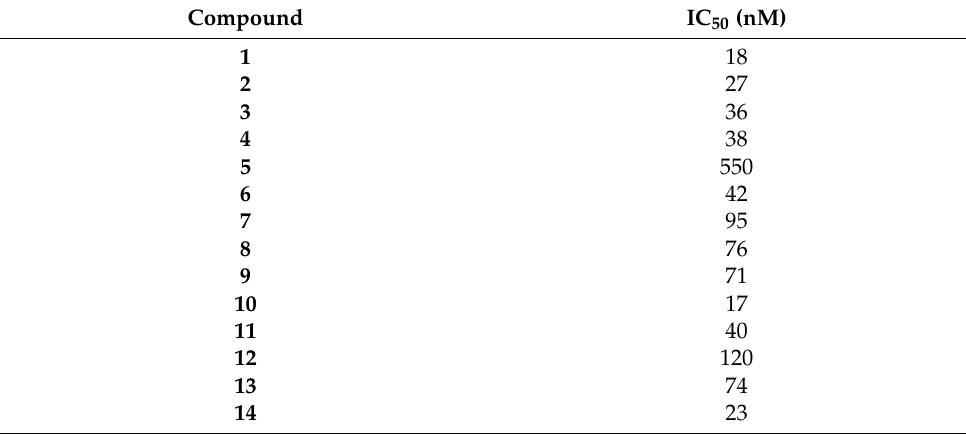
Table 3. In vitro antimalarial activities of compounds against the chloroquine-sensitive 3D7